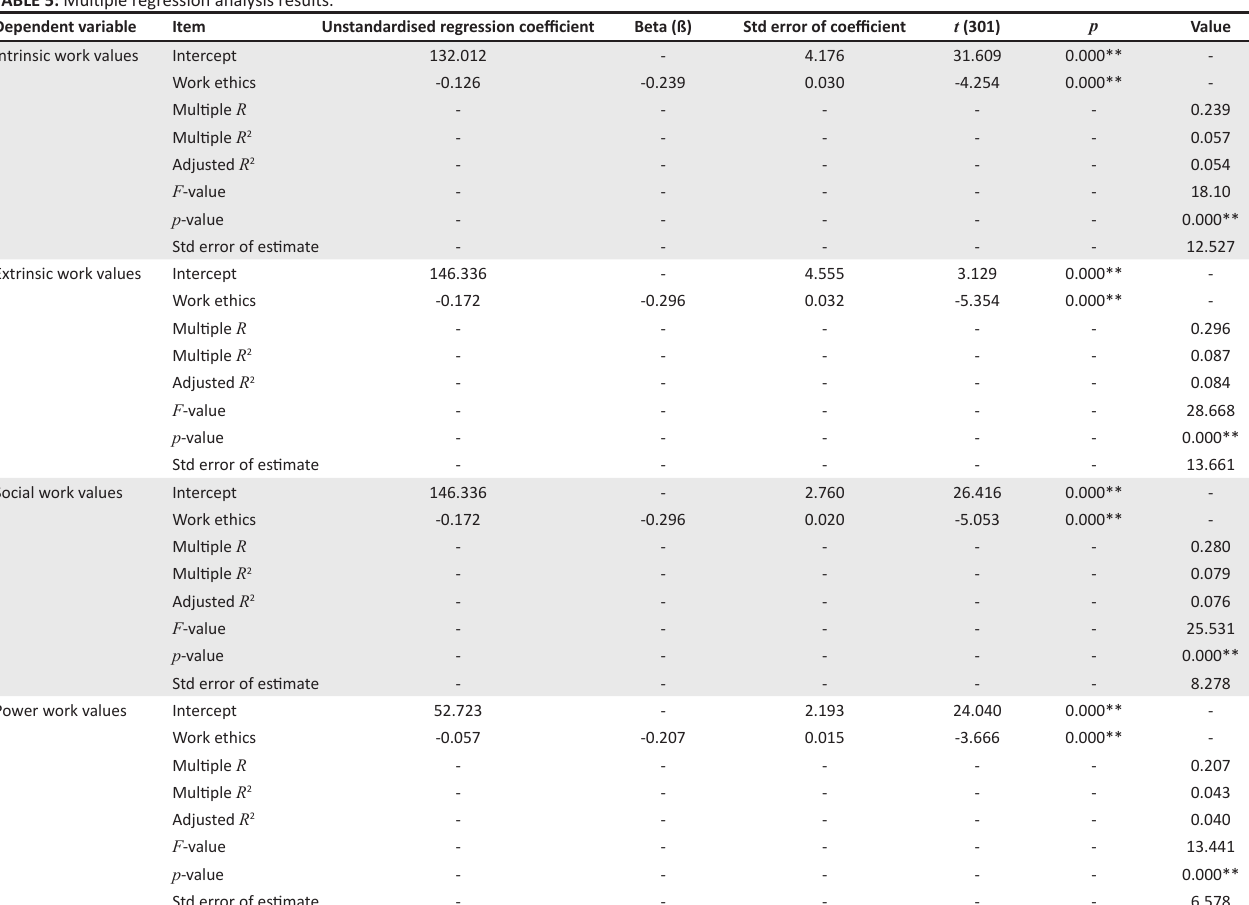
TABLE 5: Multiple regression analysis results. Dependent